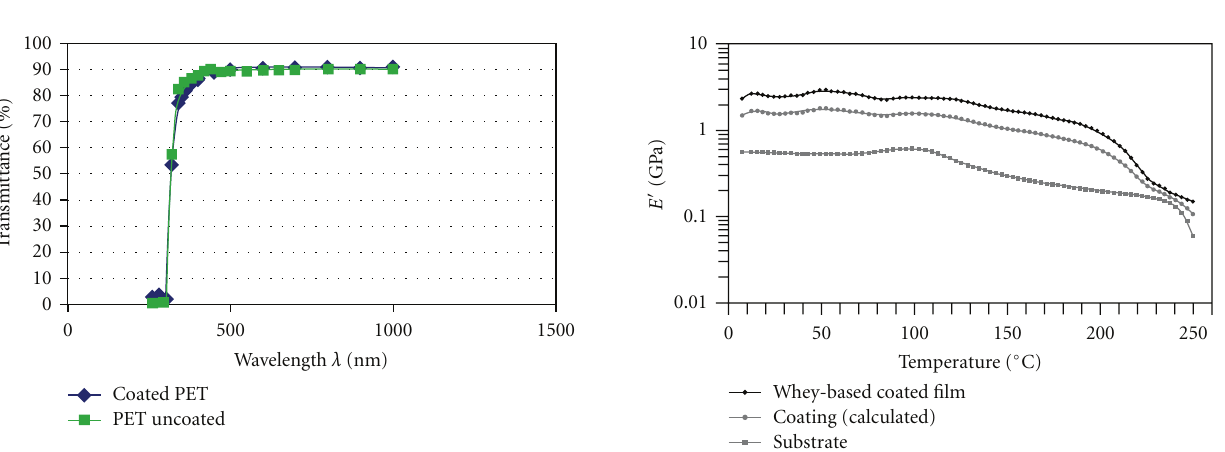
Figure 3: Transmittance spectrum of uncoated and whey-coated PET. Figure 4: Comparison of the evolution of Young’s modulus versus temperature of whey-based coated films, coating (determined applying the theory of composite materials in “isodeformation conditions”) and